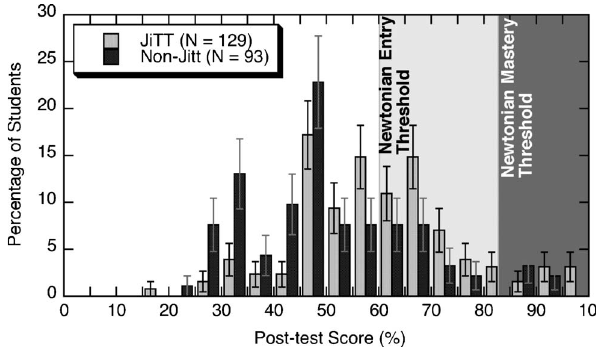
FIG. 1. Post-test scores on the FCI for two groups, JiTT (cid:1) gray bars (cid:2) and Non-JiTT (cid:1) black bars (cid:2) .